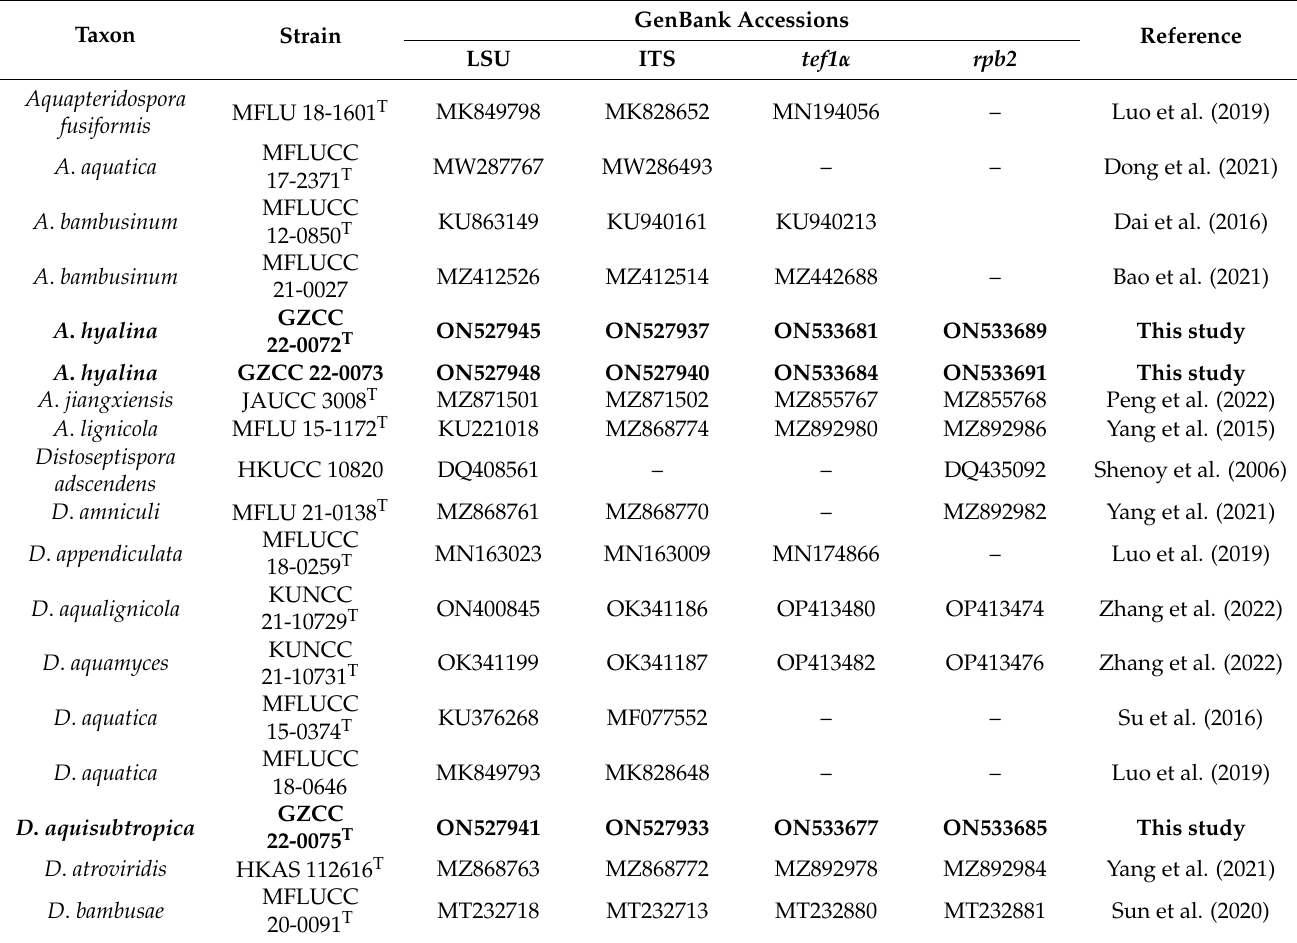
Table 2. Taxa used in this study and the GenBank accession numbers of DNA